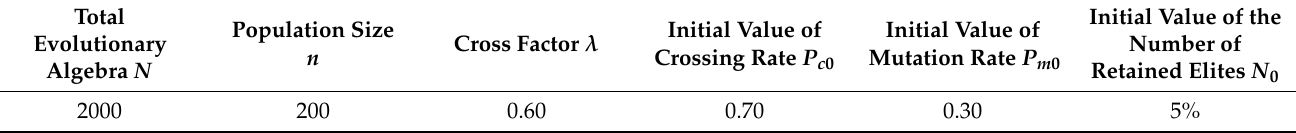
Table 3. Value of optimization model parameters.